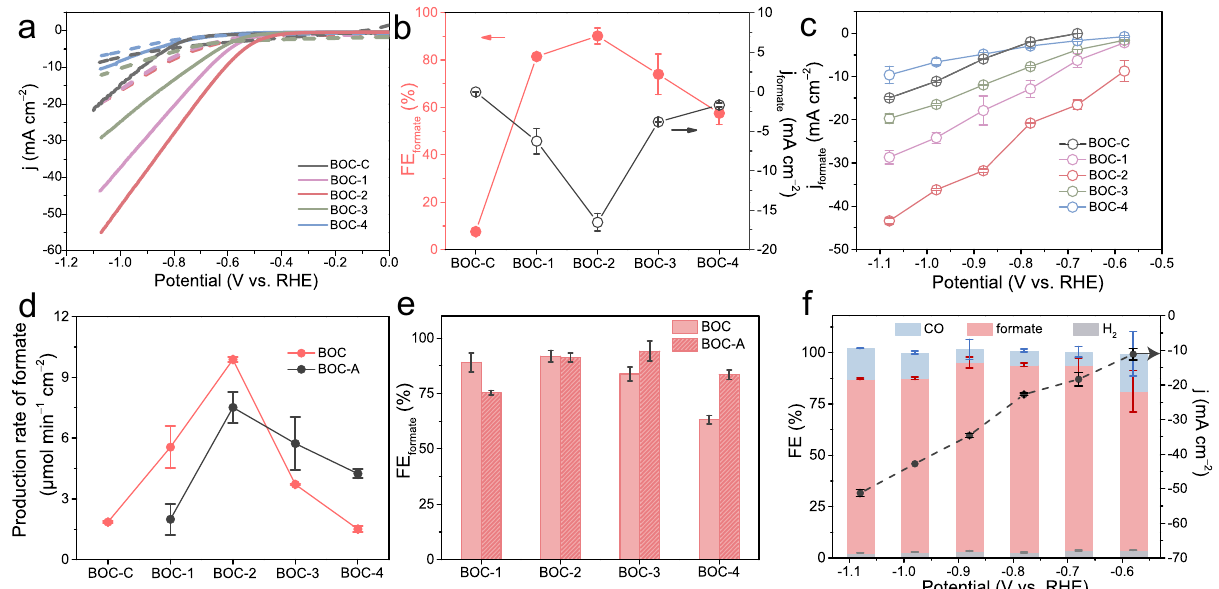
Fig.2|ElectrochemicalCO 2 RRperformance.a LSVcurvesofBOC-C,BOC-1,BOC- 2, BOC-3 and BOC-4 in Ar-saturated (dashed lines) and CO 2 -saturated (solid lines) 0.5M KHCO 3 solutions. b FE formate and j formate of BOC with differnt V O concentra- tions at − 0.68V. c j formate on different samples as function of applied potentials. d Theproductionrateofformateforallsamplesat − 0.88V.Theredandblacklines